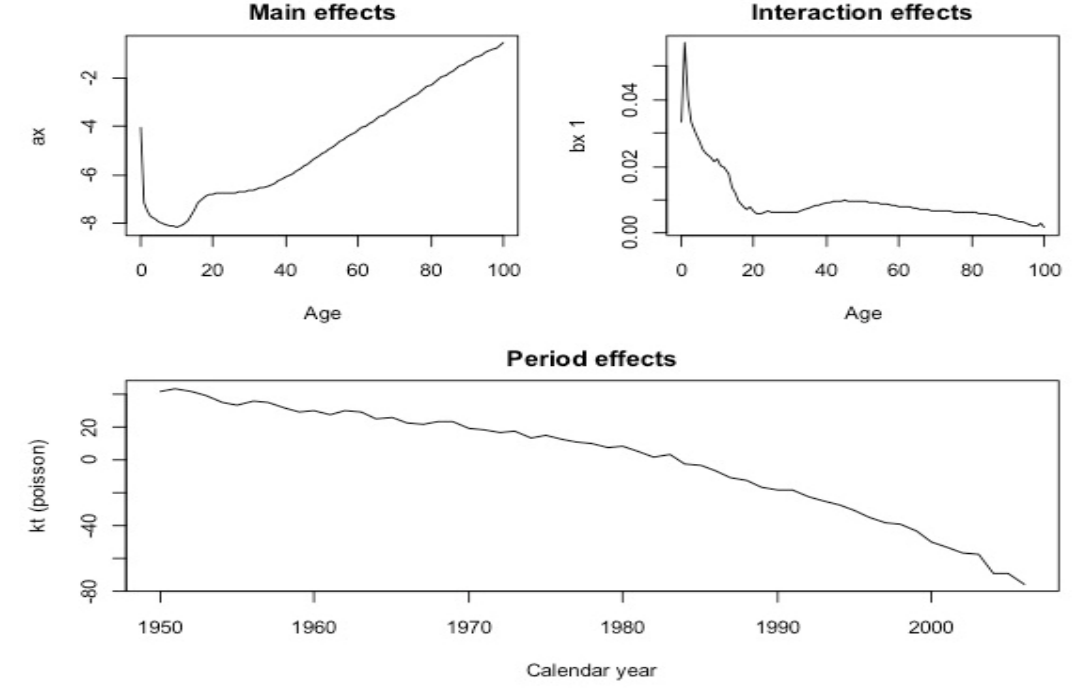
Figure 1. Model parameters, U.K. male.